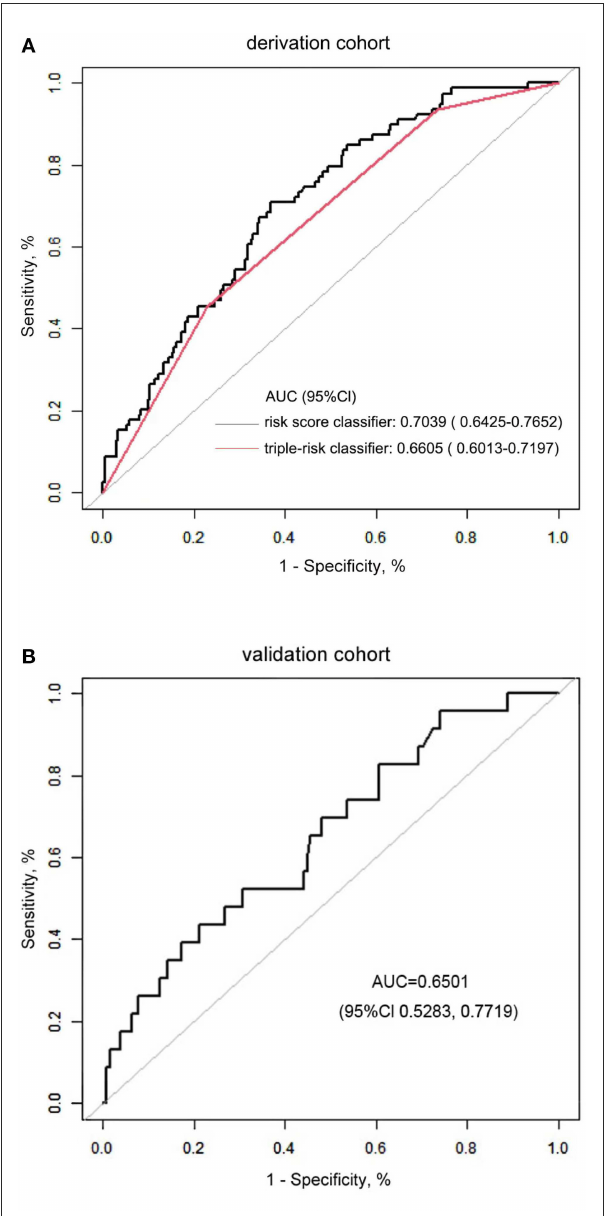
FIGURE3 (A) Comparison of the risk score classifier and the triple-risk (i.e., low, intermediate, high) classifier. AUC indicates the area under the receiver operating characteristic curve. (B) The performance of the risk score classifier in the validation cohort.